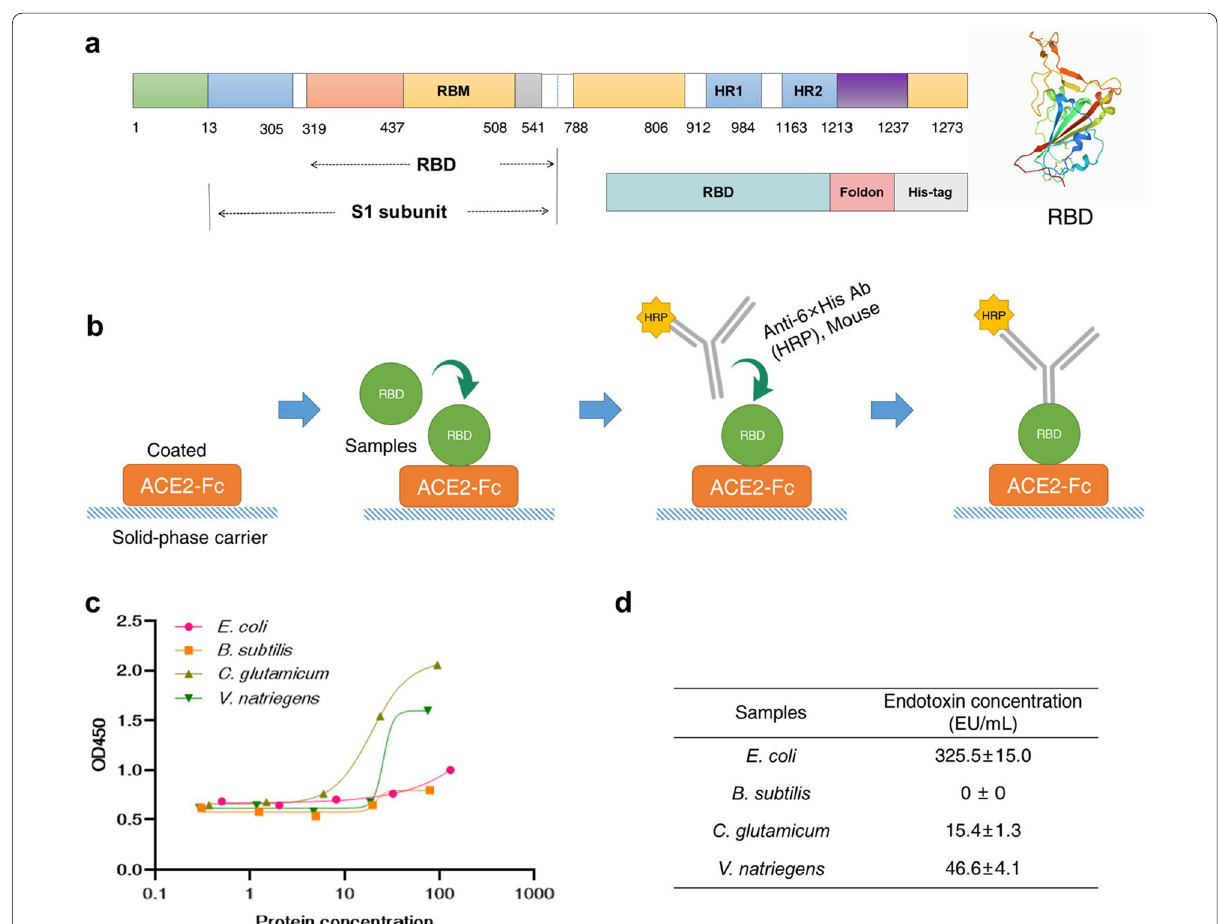
Fig. 6 The E. coli , B. subtilis , C. glutamicum and V. natriegens CFPS systems as a platform for pharmaceutical protein synthesis. a Protein structure diagrams and sequence design diagrams of RBD protein (PDB: 6VW1). b Schematic diagram of ELISA principle. c Absorbance of four system protein samples with different concentrations at 450 nm. d Endotoxin detection of extracts in the four CFPS